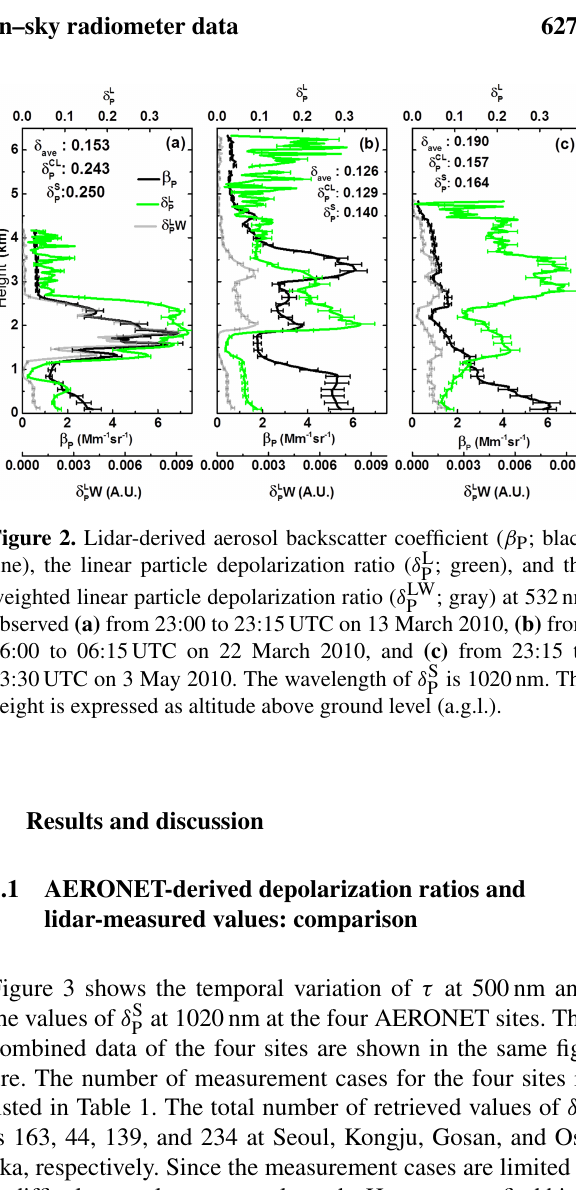
; green), and the P ; gray) at 532nm P is 1020nm. The P